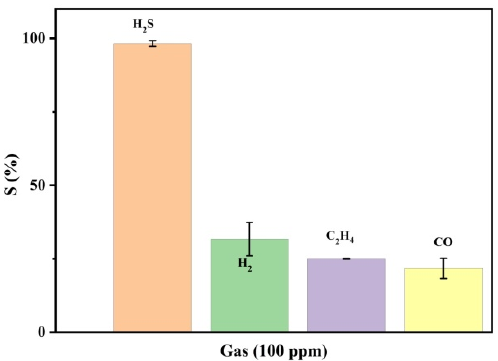
Figure 8. Selectivity of the Cu-MOF/PVA/IL membrane to H 2 S in comparison to H 2 , C 2 H 4 , CO gases at 100 ppm at room temperature.